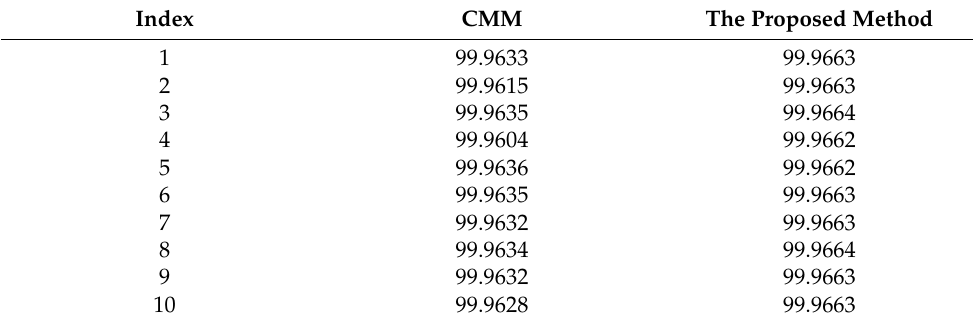
Table 5. The results of diameter measurements with a certain section of crankshaft (mm).